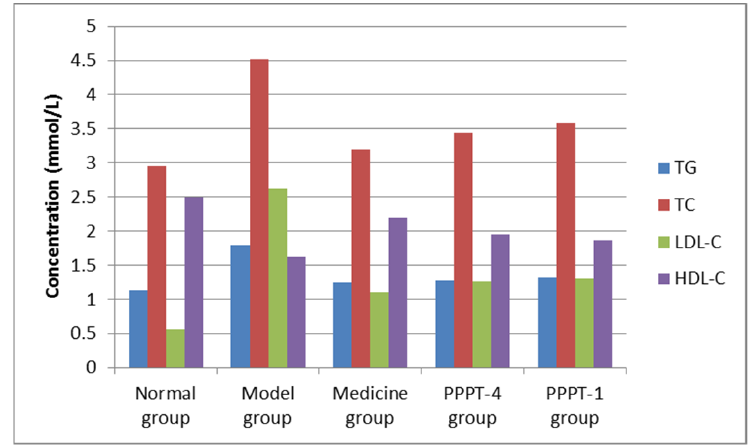
Figure 7. Effect of PPPT on TG, TC, LDL-C, and HDL-C of type II diabetic mice.